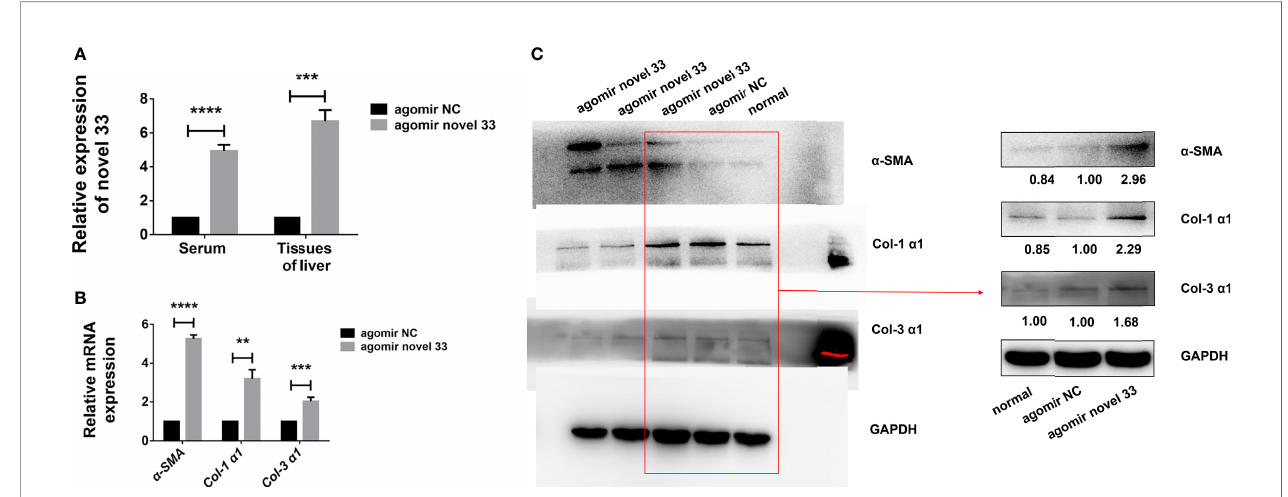
FIGURE 3 | Novel miRNA-33 agomir causes liver fi brosis in mice. Six-week-old female C57BL/6 mice were injected with agomir NC (Ribo), agomir novel 33 (Ribo), or normal saline once a week for 6 weeks. Results were compared with the agomir NC group; the normal group was only used as a reference without comparative analysis. Only the gray values of the agomir NC group and the agomir novel 33 group were statistically analyzed, the blank group was not analyzed. (A) Novel miRNA-33 levels in mouse liver and serum were increased signi fi cantly. (B) qPCR results showing upregulation of a -SMA, Col 1 ( a 1) , and Col 3 ( a 1) at the mRNA level. (C) Western blotting results showing upregulation of a -SMA, Col 1 ( a 1), and Col 3 ( a 1) at the protein level. The abundances of a -SMA, Col 1 ( a 1), and Col 3 ( a 1) proteins were normalized against GAPDH, and miRNA expression levels were normalized against U6. Results are averaged from three independent experiments, and Student ’ s t -tests were applied to assess differences between two groups (** p < 0.001, *** p < 0.0005, **** p <